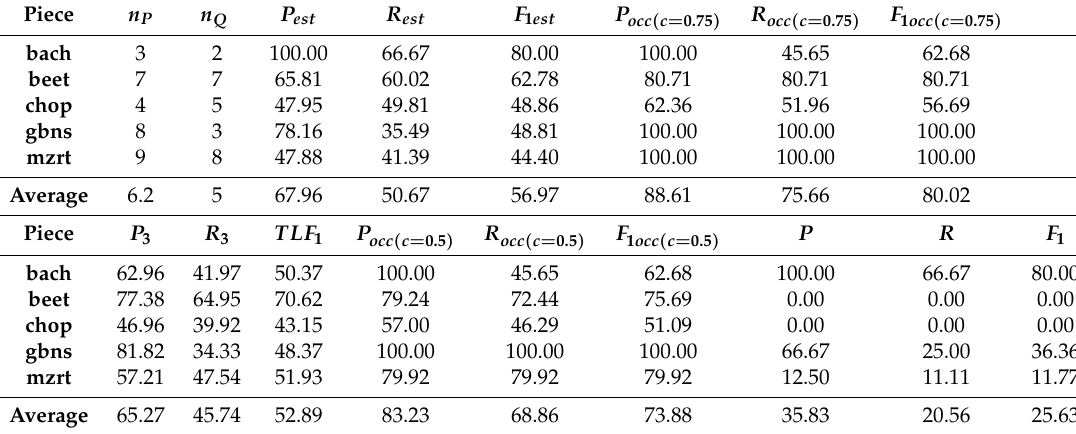
Table 3. A detailed list of JKU Patterns Development Dataset results for the SymCHMMerge approach. The n P and n Q columns represent the number of annotated patterns and the number of discovered patterns respectively. Song names are shortened, using a four letter abbreviation of the composer’s